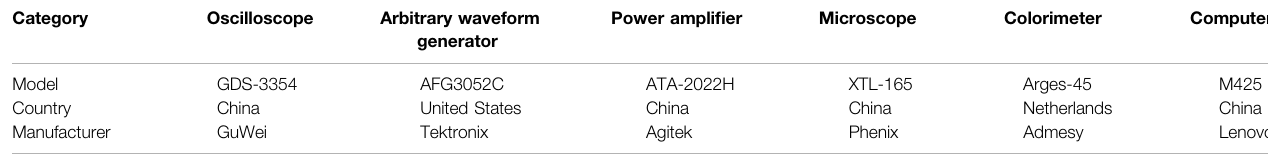
TABLE 1 | Experimental platform for testing EWDs.